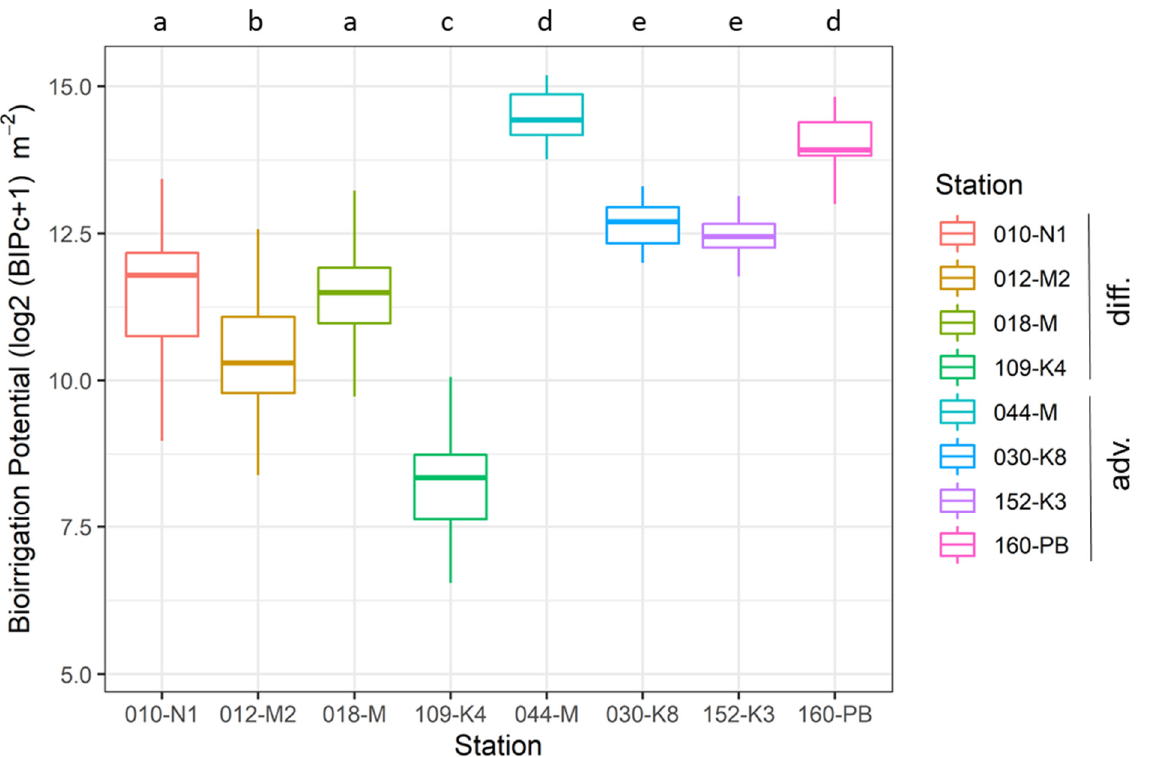
Figure 2. Boxplots showing the variability in BIPc over the years (two decades) at eight monitoring stations. Stations are first sorted according to the type of system (diffusion- or advection-driven) and then according to decreasing salinity. Subsets sharing the same letter above the plots are not significantly different (based on ANOVA and Tukey honestly significant difference test). The locations of the stations are indicated in Figure 1.